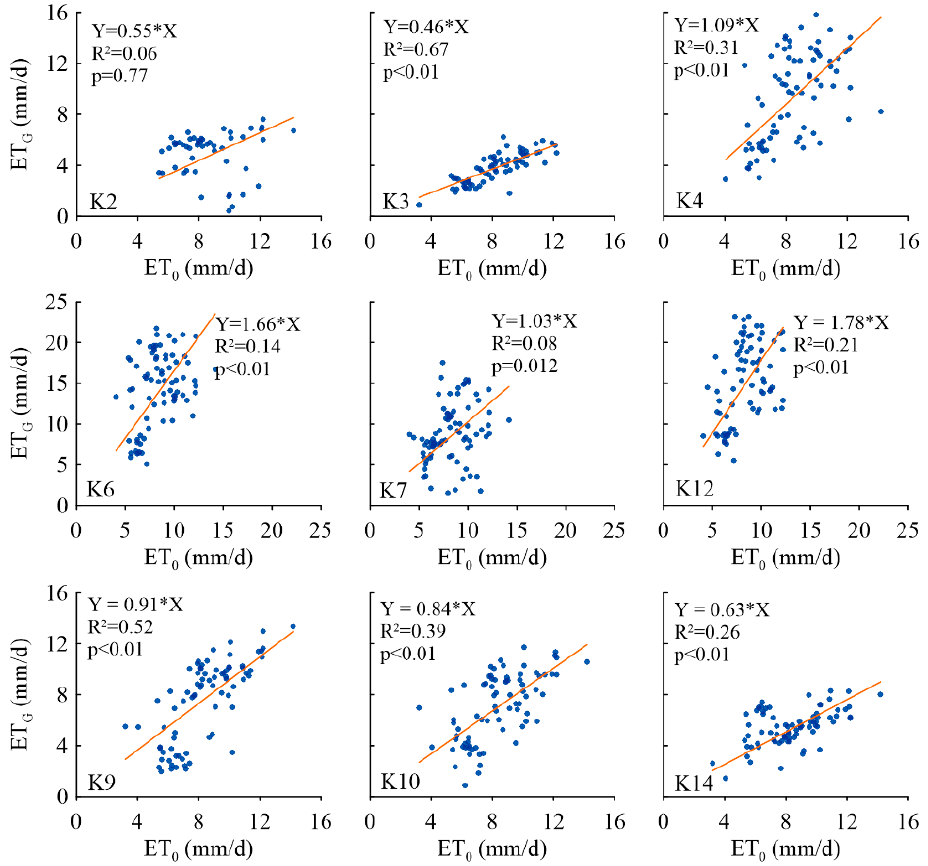
Figure 8. The relationship between ET 0 and ET G for different observation wells.